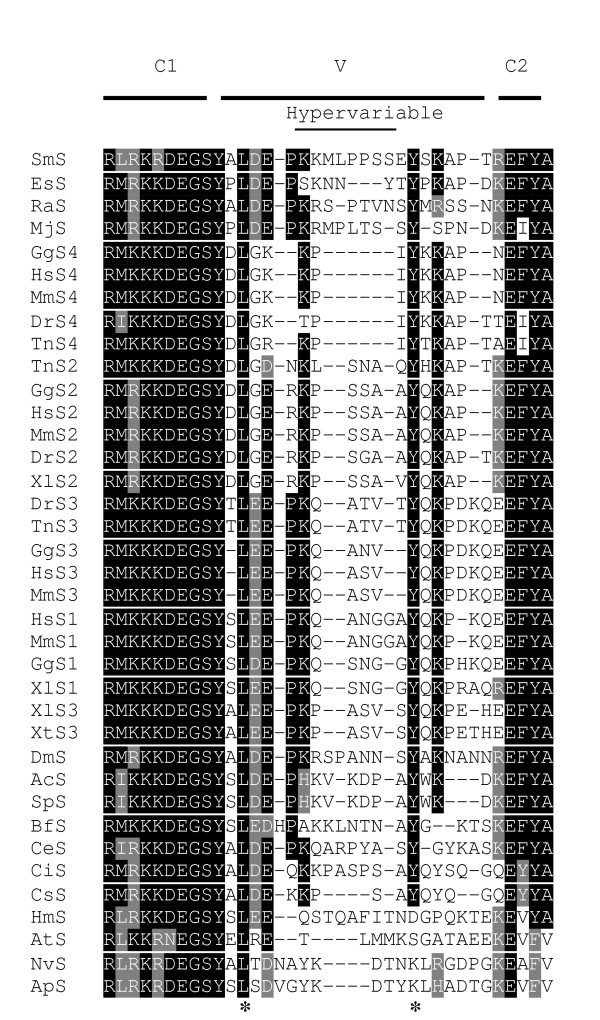
Conservation of syndecan cytoplasmic domains. Amino acid sequences of syndecan cytoplasmic domains from different species were aligned in ClustalW. The alignment is presented in Boxshade 3.2. Black shading shows identical amino acids; gray indicates conservative substitutions and no shading indicates unrelated amino acids. V = variable region and the very highly-conserved leucine and tyrosine residues are indicated by asterisks. The central hypervariable region (13) is also indicated. Key: Ac, Anthocidaris crassispina; Ap, Acropora palmata; At, Acropora tenuis; Bf, Branchiostoma floridae; Ce, Caenorhabditis elegans; Ci, Ciona intestinalis; Cs, Ciona savignyi; Dm, Drosophila melanogaster; Dr, Danio rerio; Es, Euprymna scolopes; Gg, Gallus gallus; Hm, Hydra magnipapillata; Hs, Homo sapiens; Mj, Marsupenaeus japonicus; Mm, Mus musculus; Nv, Nematostella vectensis; Rp, Rhipicephalus appendiculatus; Sm, Schmidtea mediterranea; Sp, Strongylocentrotus purpuratus; Tn, Tetraodon nigroviridis; Xl, Xenopus laevis; Xt,Xenopus tropicalis. All syndecans are abbreviated as S.